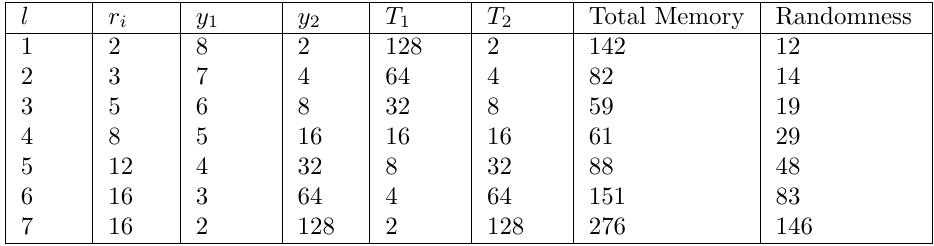
Table 3: Estimate of RAM memory required for Algorithm 6 for an (8,8)-bit S-box. Memory requirement (in no. of bytes) for r i ’s, y 1 ’s, y 2 ’s, T 1 , T 2 , are also listed separately. The last column corresponds to the total number of random bytes required for r i , y 1 and y 2 ’s.